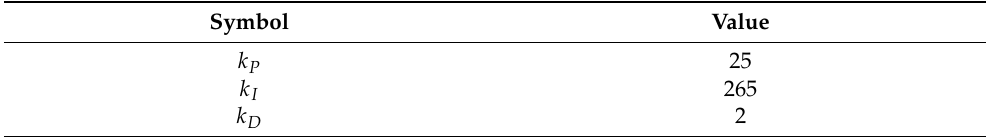
Table 4. Parameters of the PID controller.